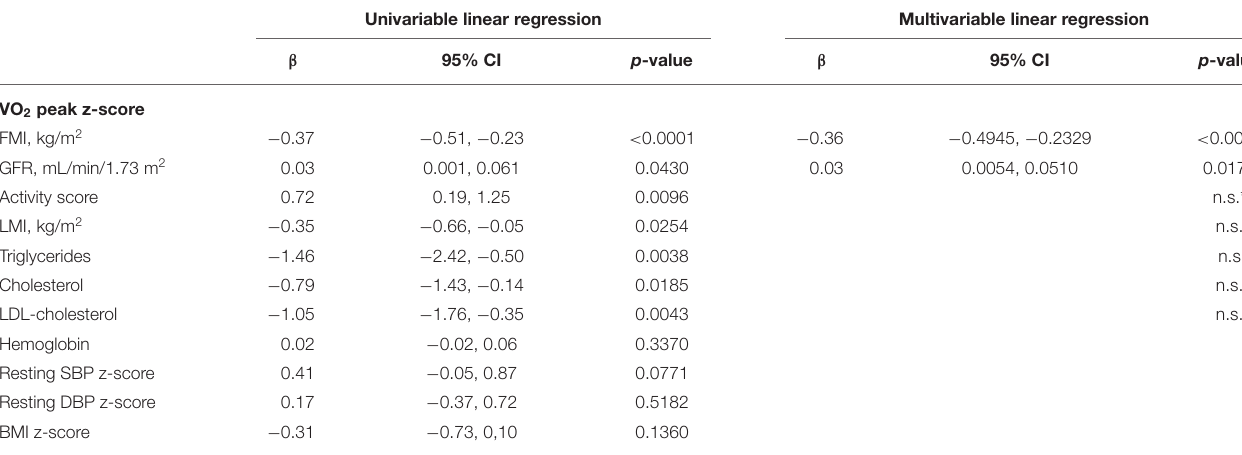
TABLE 3A | Univariable and multivariable linear regression of VO 2 peak z-score in 38 kidney transplanted children. Univariable linear regression Multivariable linear regression